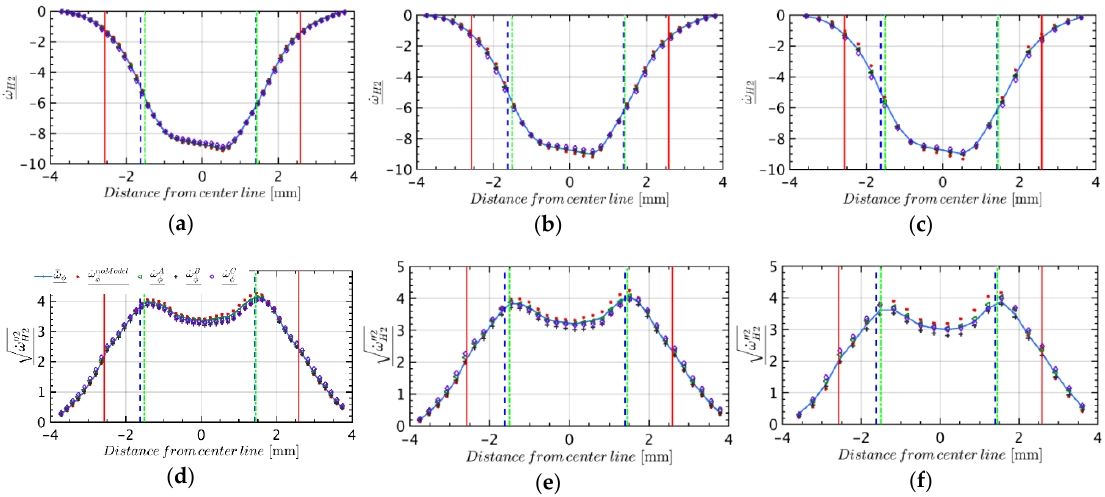
Figure 7. Production/consumption rate of H 2 with units (kg/(m 3 s)): ( a – c ) Mean; and ( d – f ) RMS. Different filter widths are applied: ( a , d ) ∆ / ∆ DNS = 8; ( b , e ) ∆ / ∆ DNS = 12; and ( c , f ) ∆ / ∆ DNS = 18. The data are extracted at t = 35 t j . Vertical lines are the same as in Figure 3.